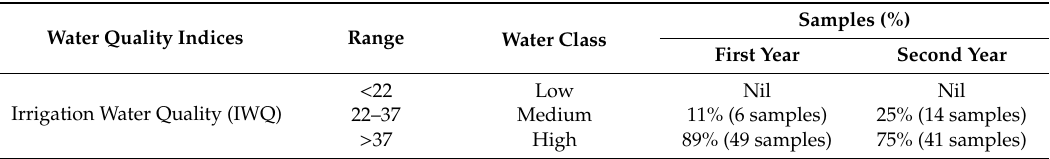
Table 5. Classification of surface water quality according to